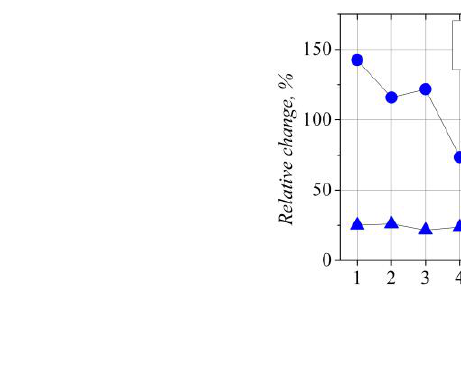
Figure 3. ( a ) Statistical representation of voltage sensitivity of some bow-tie diodes on the base of WO structures under illumination (open dots, illuminance 14,400 lx.) and in the dark (solid dots); ( b ) statistical representation of illumination‑induced relative change in voltage sensitivity ∆ S and electrical resistance R of the same WO-diodes.